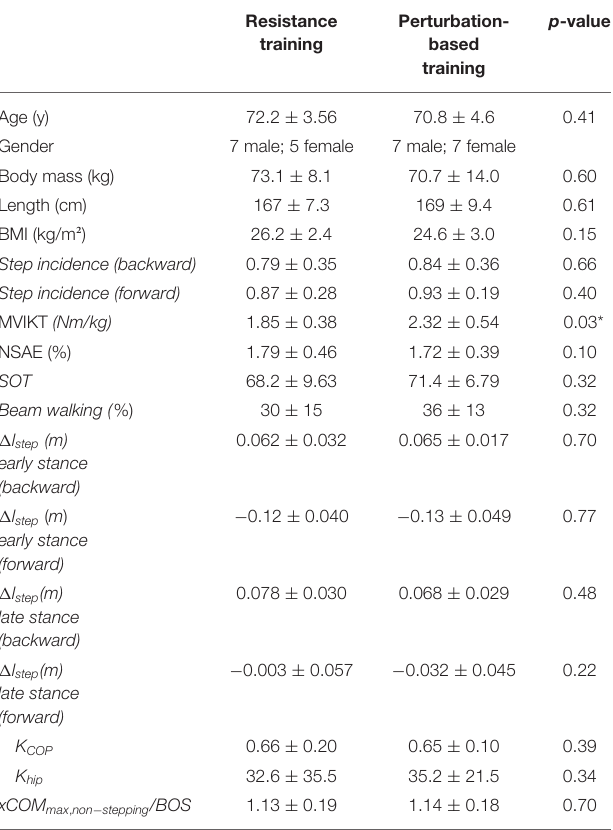
Reactive Balance TABLE 2 | Baseline comparison for the included groups of healthy older adults. Standing Reactive Balance Resistance Perturbation- Step incidence in response to backward platform translations training based (backward perturbations) of standing presented both a